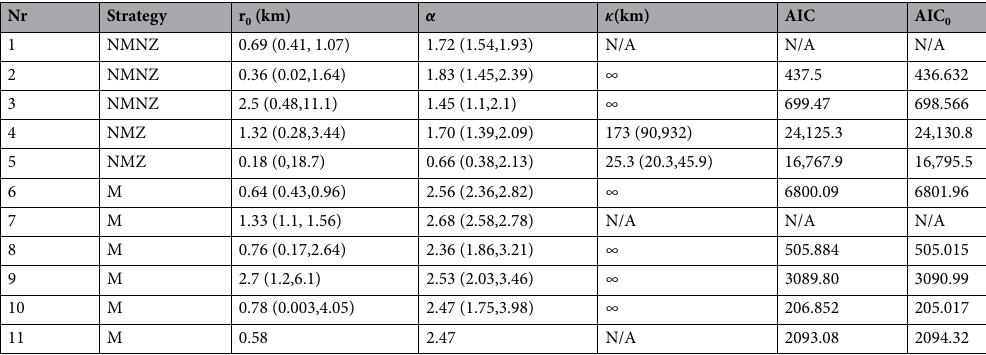
Table 3. Estimations for the 11 epidemics of the Lévy-walk kernel parameters r 0 , α and κ (with confidence bounds between brackets), the corresponding AIC, the AIC 0 for the reference kernel estimation, and the applied control strategy (in order of increasingly stringent measures: no movement ban nor zoning (NMNZ), no movement ban but zoning (NMZ), and a movement ban (M)). For the kernel parameters of the transmission kernel for FMD in Japan (epidemic 11) no confidence bounds were reported in 27